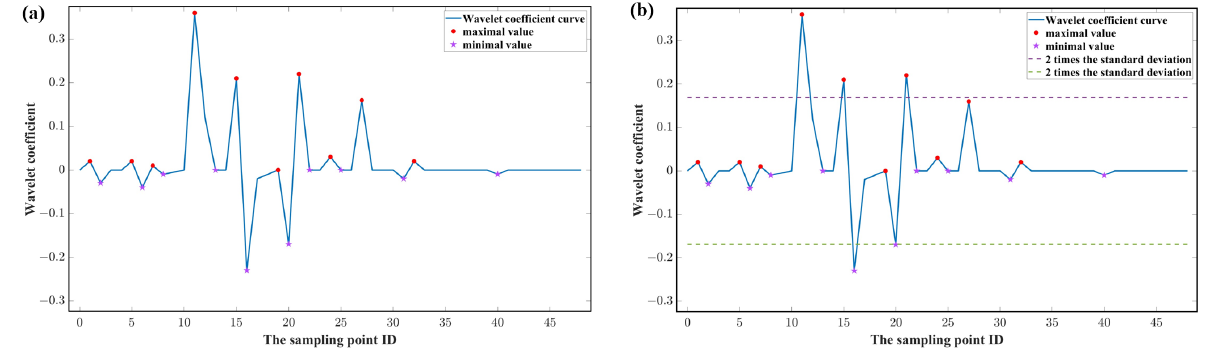
Figure 4. Elimination of “pseudo” mutation point: ( a ) “maximum module” of wavelet transform coefficients; ( b ) “pseudo” mutation points detected by k-standard deviations.